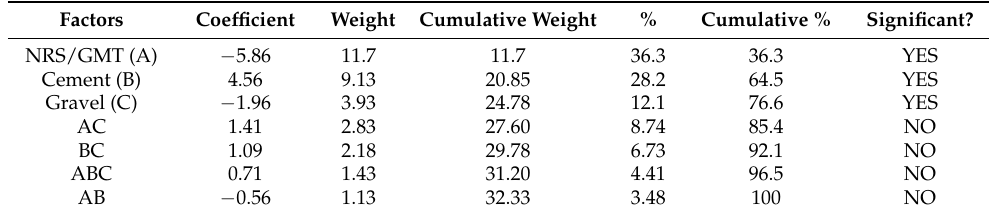
Table 7. Calculation table of the significance of the factors according to the Pareto method. Factors